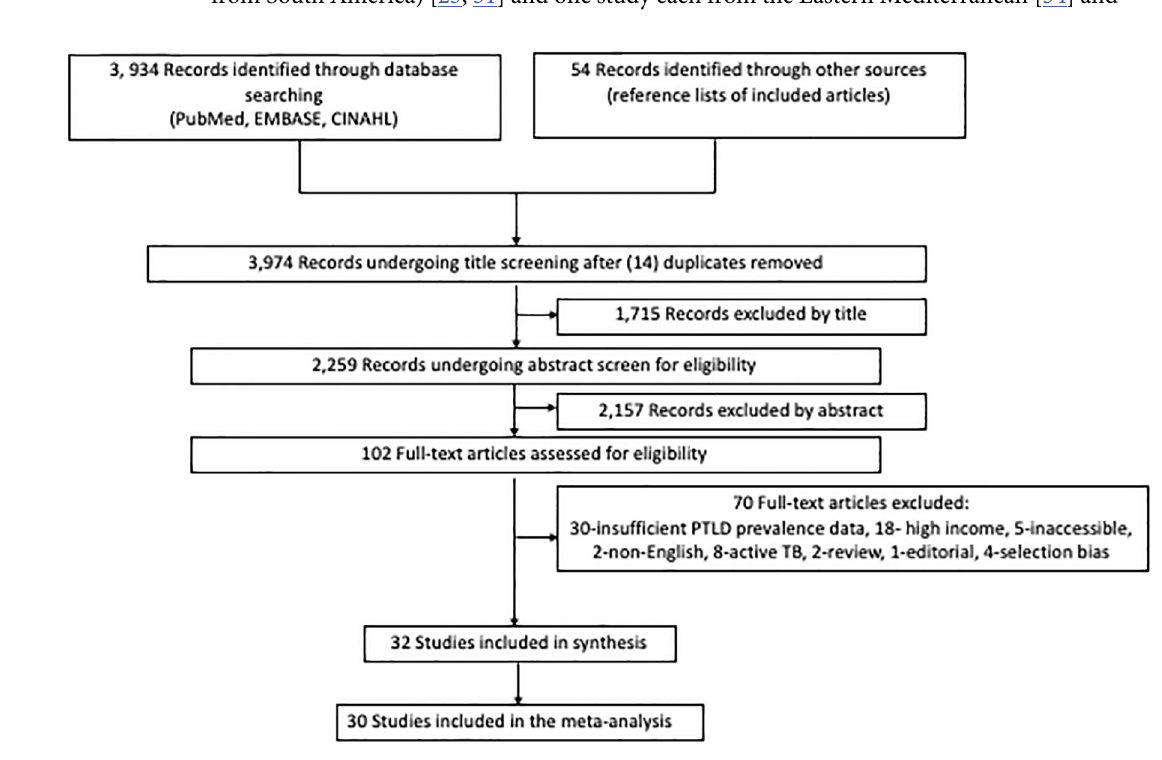
Fig 1. PRISMA flow chart. A flow chart showing study identification and selection process.